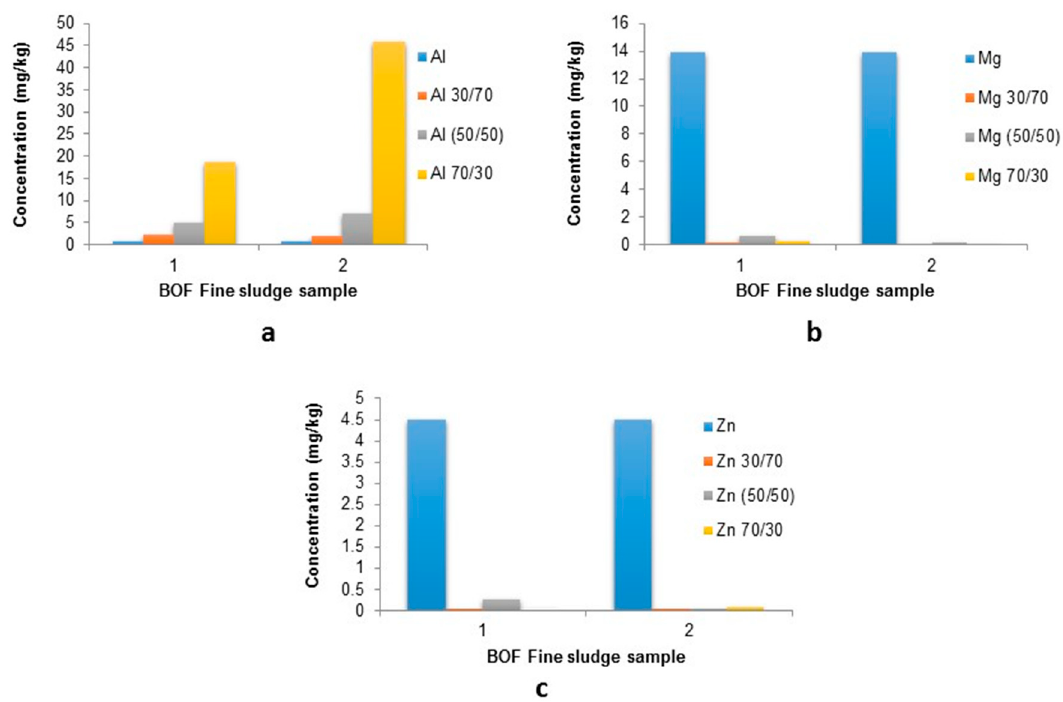
Figure 10. leachate concentrations in stabilized moulds compared to raw BOF fine sludge: ( a ) Al; ( b ) Mg; and ( c ) Zn.